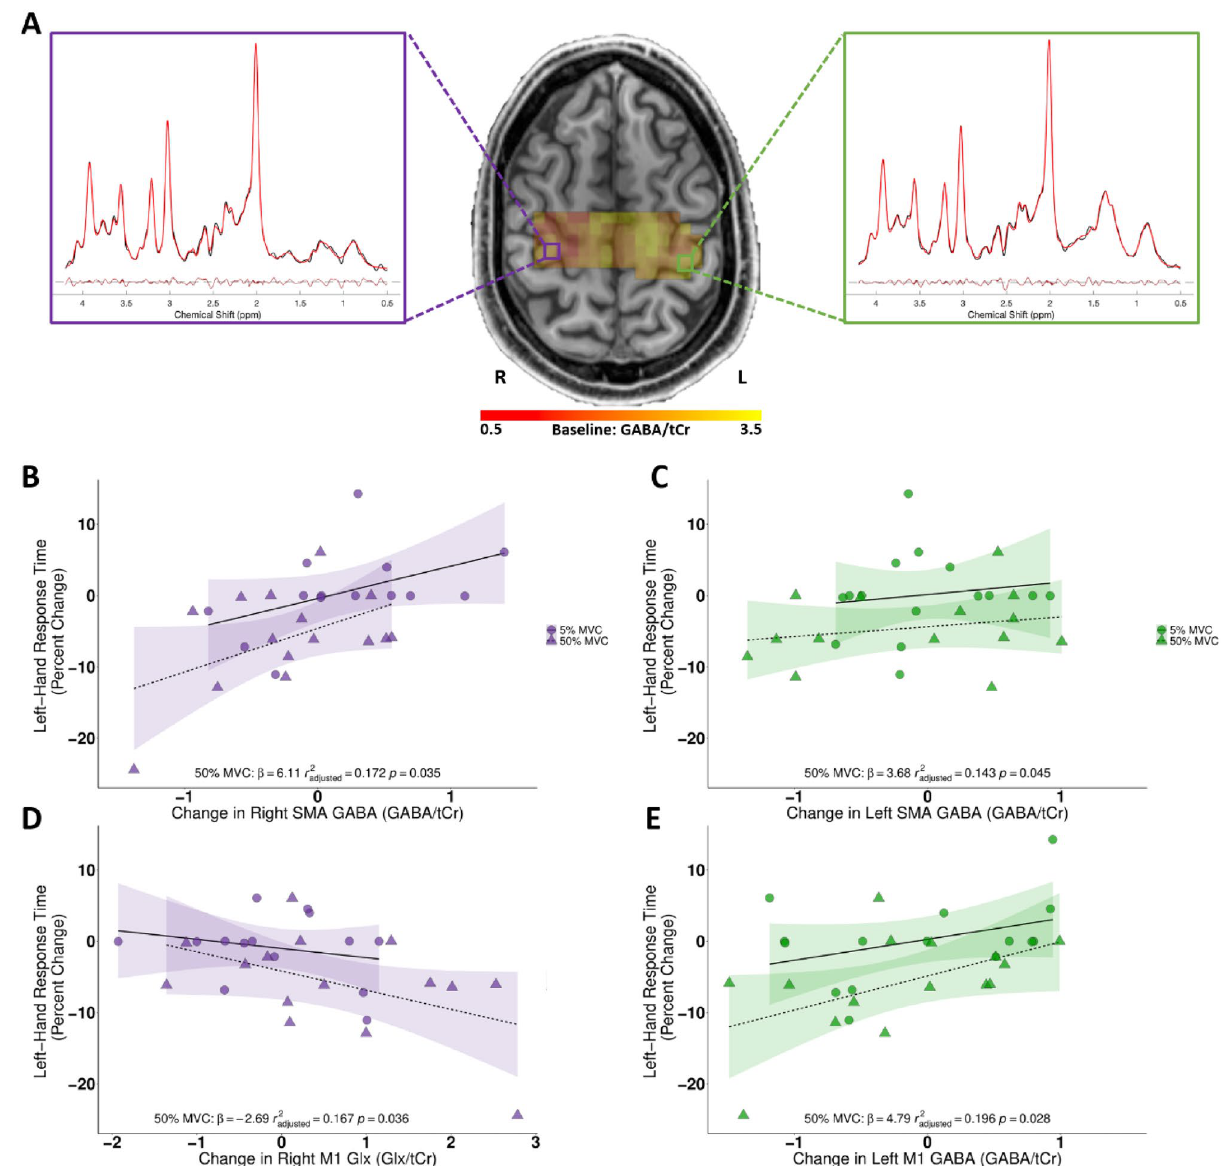
Figure 4. ( A ) Magnetic resonance spectroscopic imaging spectrum from a representative participant, with spectra from M1 voxels in each hemisphere. ( B – E ) Scatter plot correlations for the right hemisphere ( B , D ; purple) and left hemisphere ( C , E ; green) between X-axes: SMA ( B , C ; top scatter plots), M1 ( D,E bottom scatter plots) for GABA/tCr (rSMA, lSMA, lM1) and Glx/tCr (rM1) ratios with Y-axes: the change in left-hand response times (ms) after performing the right-hand force-matching task at either 5% MVC (circles) or 50% MVC (triangles) conditions. Figure 4A was made in fsleyes as part of FSL 39